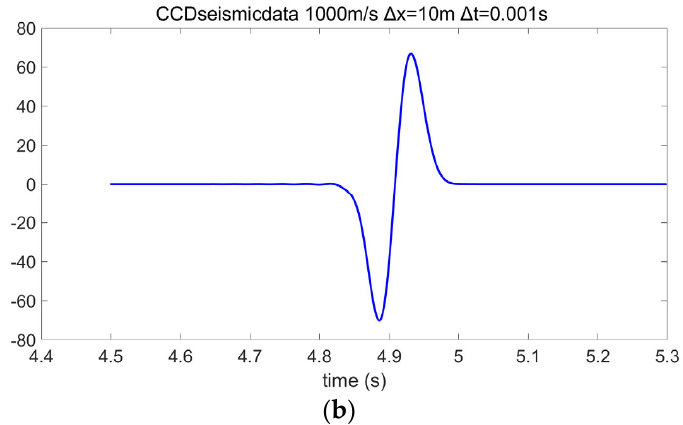
Figure 4. ( a ) CFD is used to simulate the numerical simulation of seismic records in the 1D homo ‐ neous medium model, ∆ x = 10 m; ( b ) CCD is used to simulate the numerical simulation of seismic records in the 1D homogeneous medium model, ∆ x = 10 m.